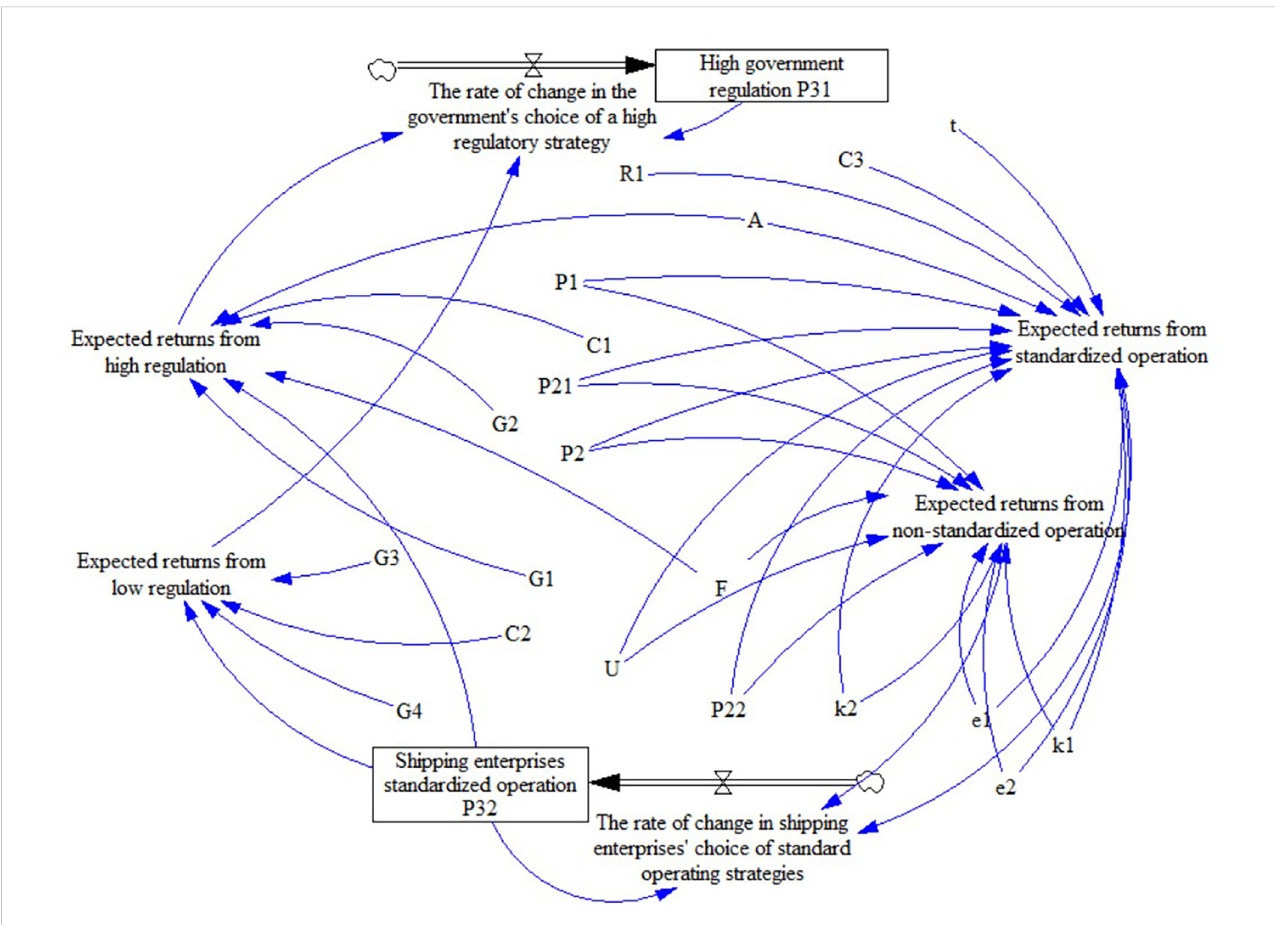
FIGURE 2 SD simulation models of governments and shipping